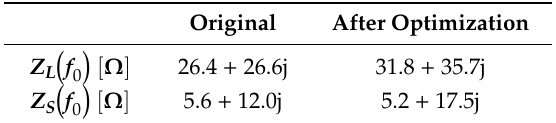
Table 2. Source and load impedances after and before optimization.